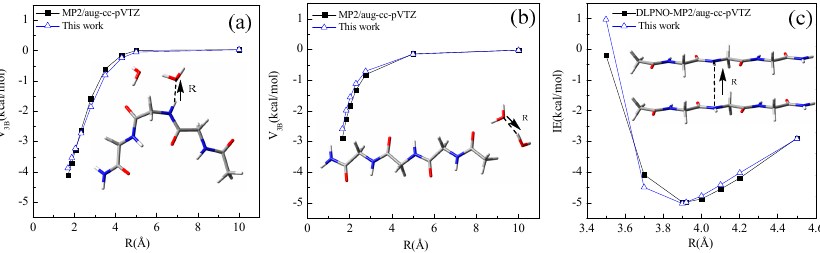
Figure 3. Interaction energy curves. ( a , b ): 3 − body interactions; ( c ): 2 − body interactions. Table 1. Parameters for nonbonded terms.